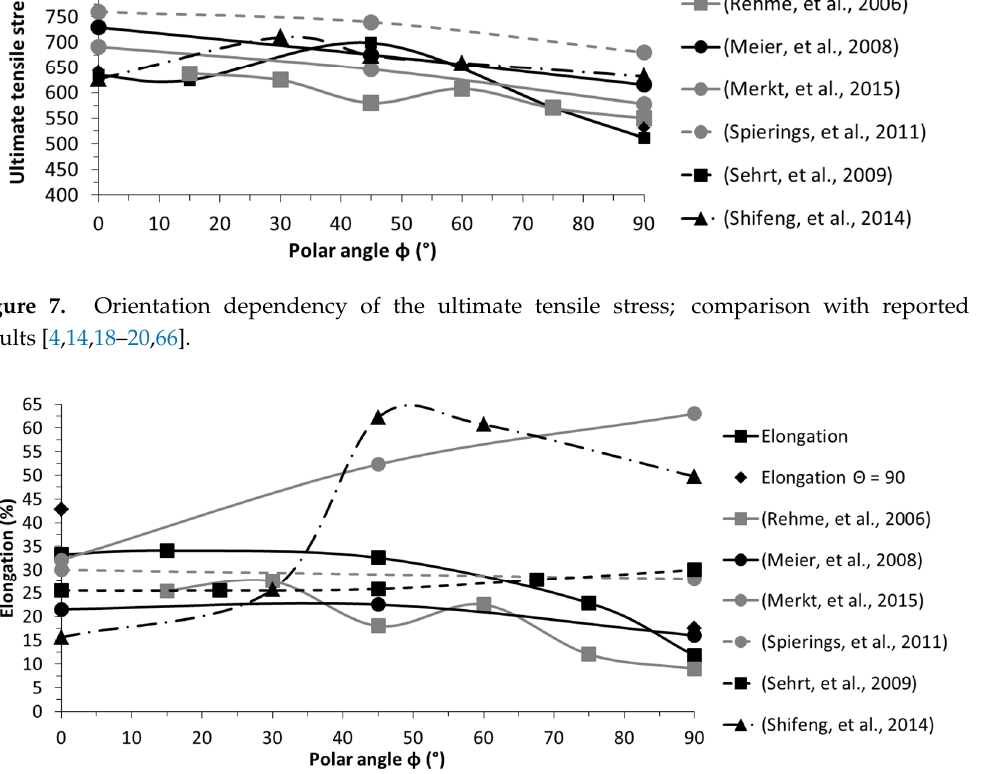
Figure 8. Orientation dependency of the elongation at fracture; comparison with reported results [4,14,18–20,66].